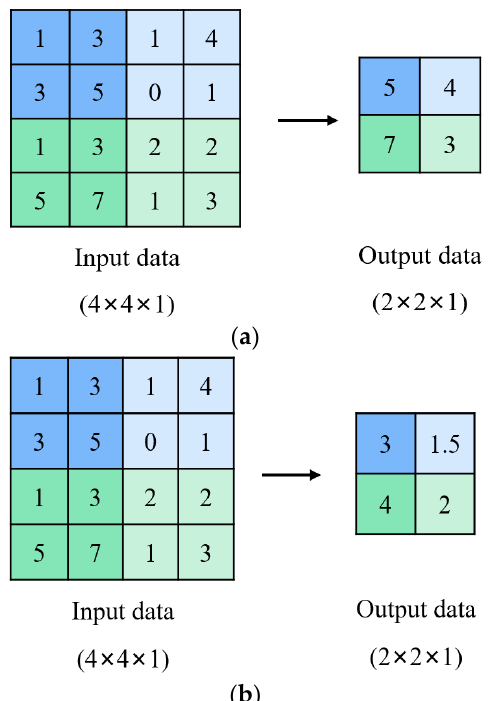
Figure 2. Schematic diagram of pooling layer calculation process ( a ) max-pooling layer ( b ) average-pooling layer (the elements in the matrix are various pixels).